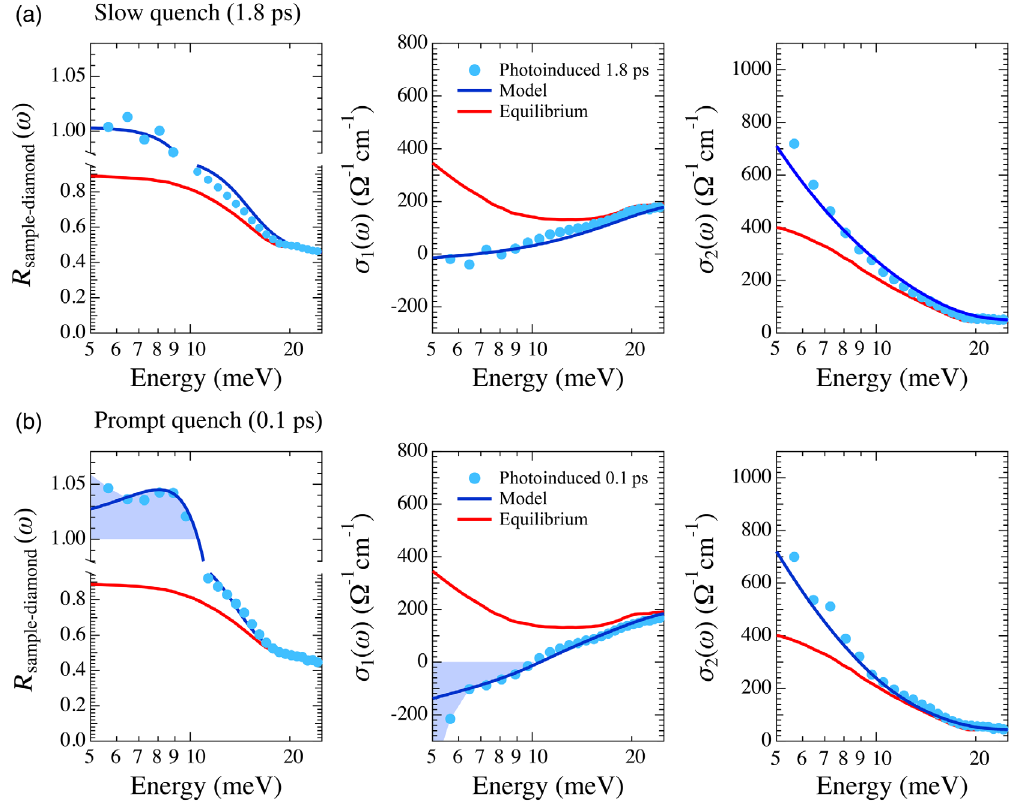
FIG. 4. (a) Reflectivity and complex optical conductivity (sample-diamond interface) of K 3 C 60 measured at equilibrium (red solid curves) and at the peak of the pump-probe response (light-blue dots) with a pump-pulse duration of 1800 fs. For nonequilibrium systems, we present inferred local quantities at the sample-diamond interface as discussed in Sec. V and Appendix A. (b) Same quantities, measured with a pump-pulse duration of 100 fs. The shaded area highlights the frequency range where amplification is observed. All data are taken at T ¼ 100 K and at a fluence of 4 . 5 mJ = cm 2 . The blue solid curves are the optical conductivity and reflectivity calculated from the theoretical model, taking into account Higgs modulations. The corresponding fit parameters are shown